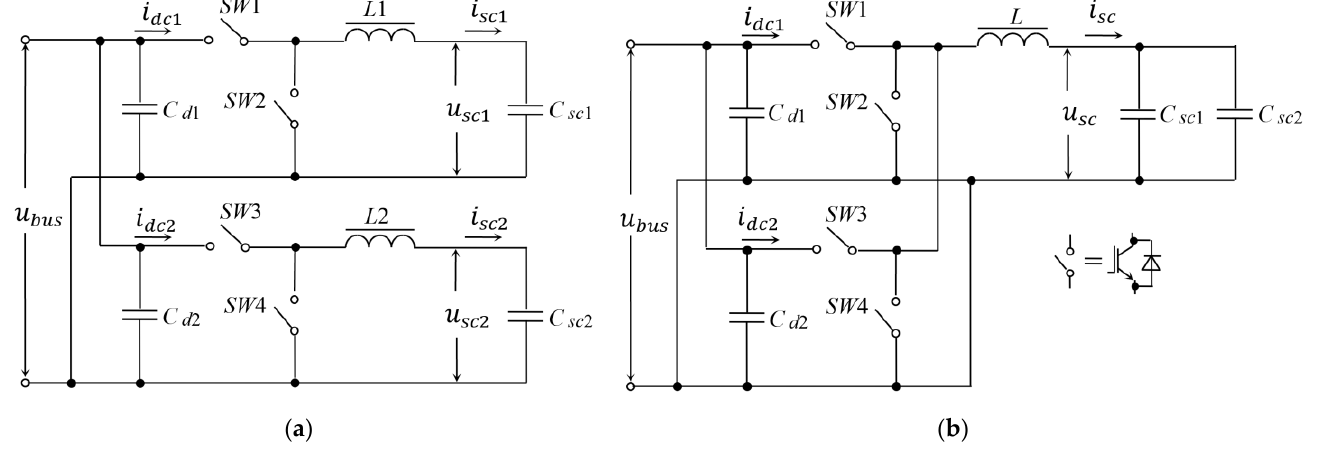
Figure 15. Parallel topology DC/DC conversion with single-phase conversion method: ( a ) option 1; ( b ) option 2. ( b ) option